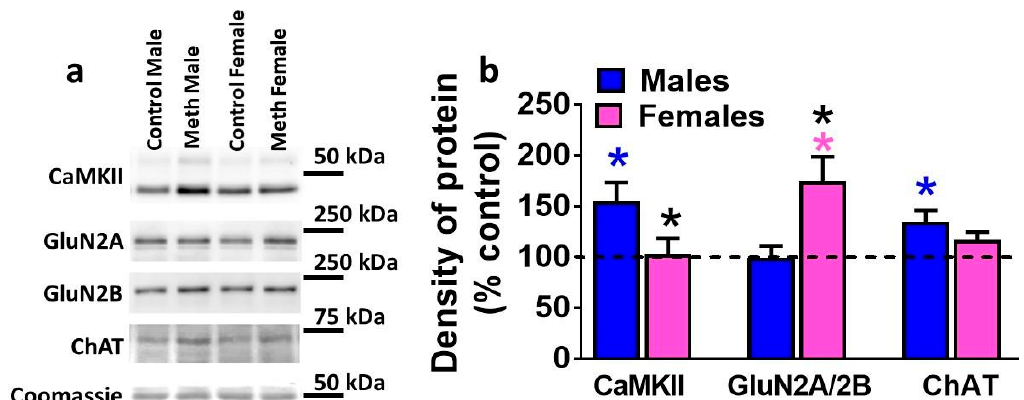
Figure 4. Plasticity related proteins are distinctly affected in male and female rats. ( a ) Representative immunoblots of each protein measured with observed molecular weight in kDa. ( b ) Quantitative analysis of density of proteins shown in b. Data shown are represented as mean ± SEM. n = 12–19 males, n = 8–13 females. * p < 0.05 vs. control males, * p < 0.05 vs. reinstated males; * p < 0.05 vs. control females by post-hoc tests.